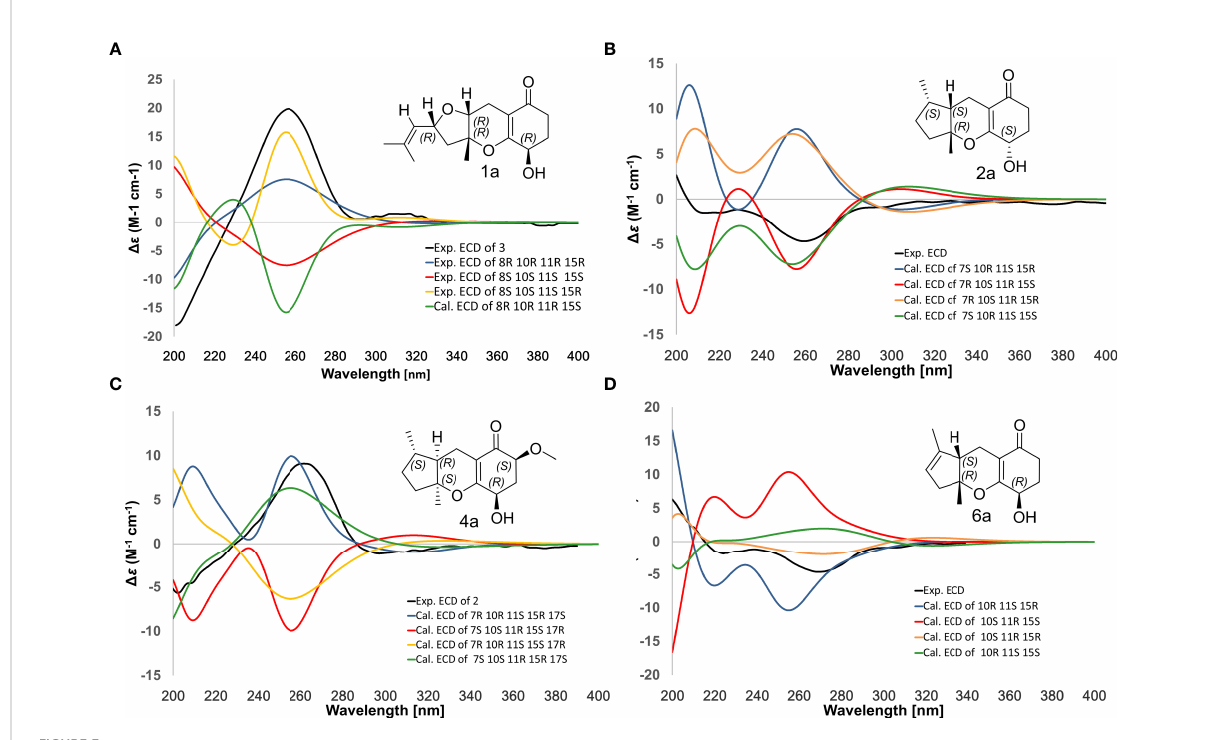
(Figure 3D), the absolute con fi guration at C-10, C-11, and C-15 was proposed to be 10 R , 11 S , 15 R